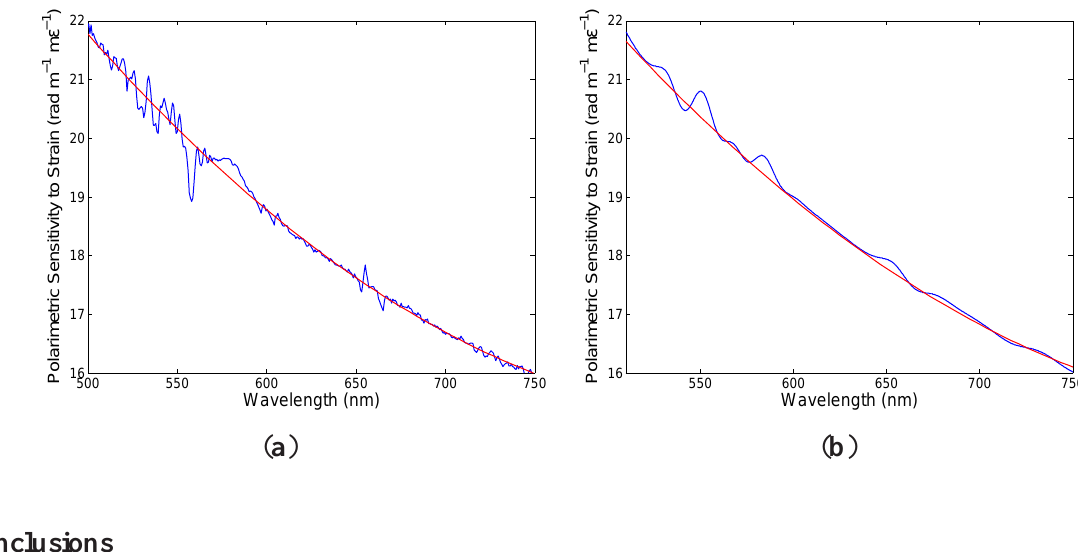
Figure 8. The spectral polarimetric sensitivity to strain: first delay ( a ), second delay ( b ). The red lines are the approximate quadratic dependences obtained from eight